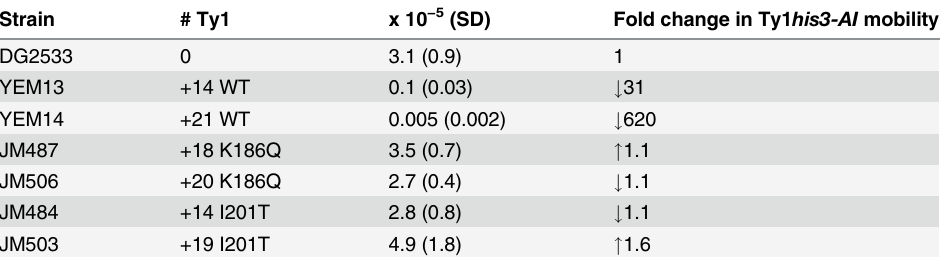
Table 2. Ty1 his3-AI mobility in CNC-resistant Ty1 repopulated strains.